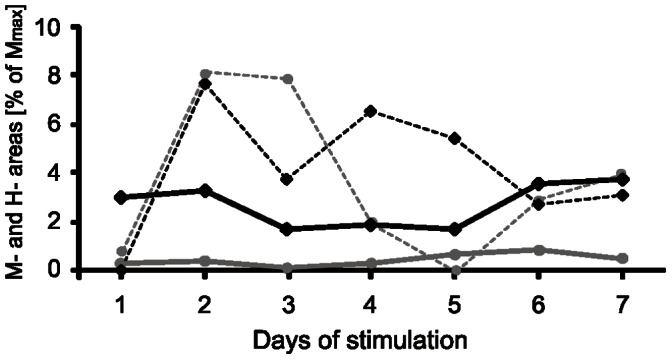
Time course of amplitude changes of the M- response and H- reflex evoked by electrical stimulation of the tibial nerve in the rat.Two stimulation patterns were used: continuous bursts of stimuli (solid lines: black – H reflex, grey – M response) or single stimuli (dashed lines: black - H reflex and grey – M response). The averaged responses to the single stimuli consisted of 30 reflexes collected at the beginning of the first and at the end of the last stimulation sessions daily in one animal. The averaged responses to burst of stimuli were collected during 3 min periods at the beginning and the end of every daily session. The strength of stimulation was established near the threshold of activation of the motor fibers, which is higher than that of Ia afferents, therefore stimulation elicited a moderate H-reflex as the majority of Ia fibers are already excited when the direct motor response (M) is at its threshold.